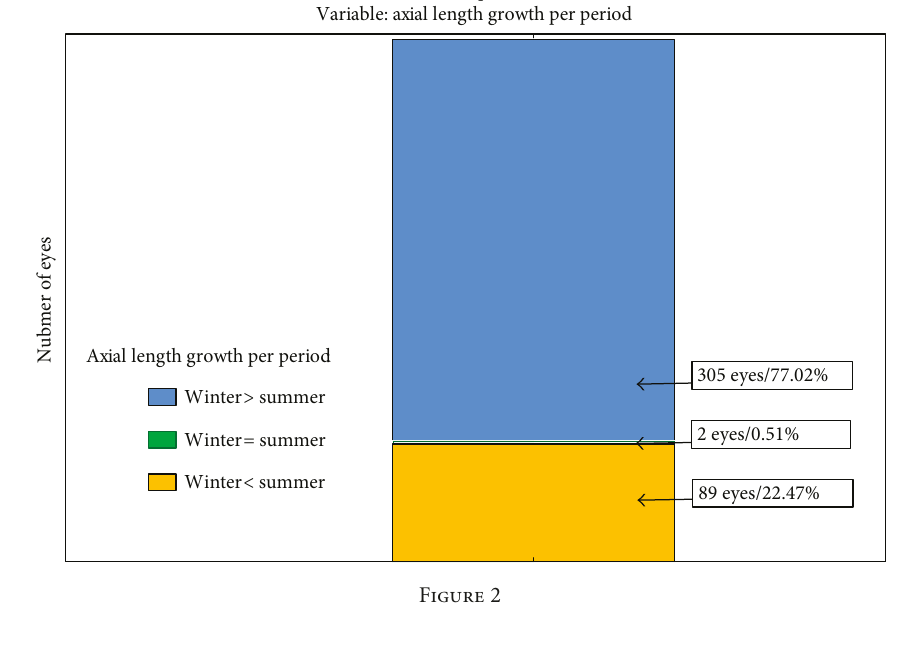
Parametric repeated ANOVA Vertical bars denote 0.95 confidence intervals